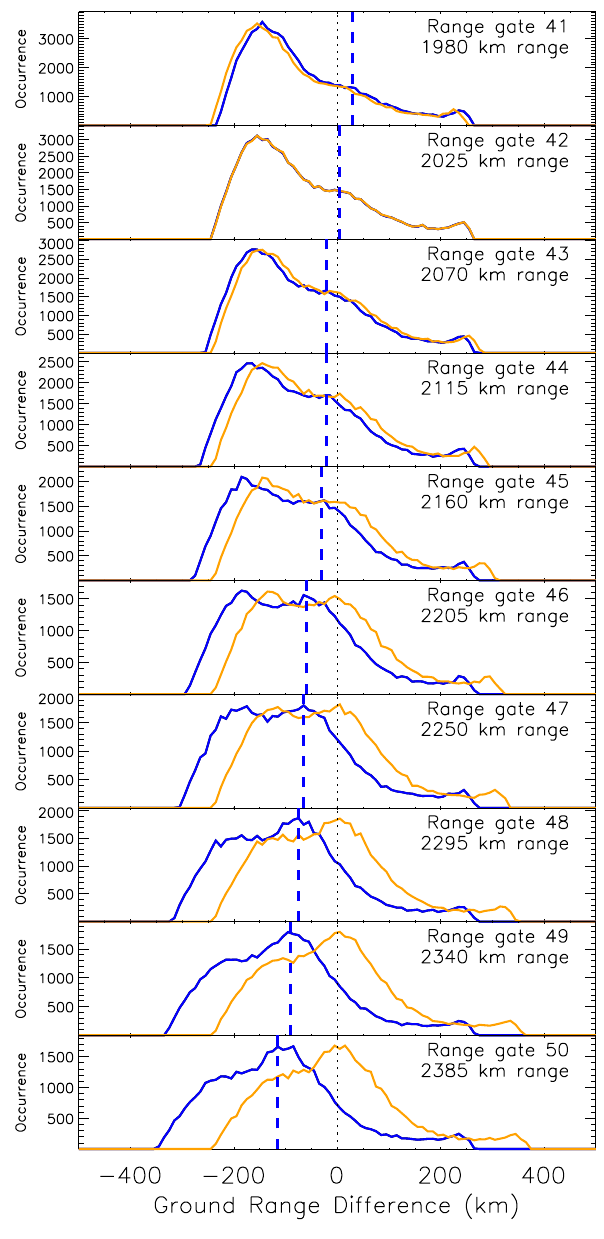
Fig. 16. Ground range difference distributions in the 1 1 1 -hop F-region overlap region comparing the performance of the 2 1 -hop F-region model (blue distributions) and the 1 1 2 model (yellow distributions) when the measured backscatter is as- sumed to be truly 1 1 -hop. The distributions are shown at every 2 range gate from range gate 41 (1980km range; top panel) to range gate 50 (2385km range; bottom panel). The vertical dashed blue lines highlight the 1 1 -hop backscatter peak of the blue distribu- 2